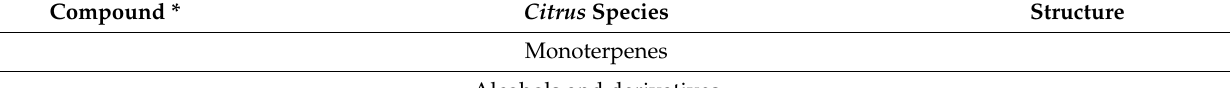
Table 1. Essential oils reported from peels of Citrus fruits.